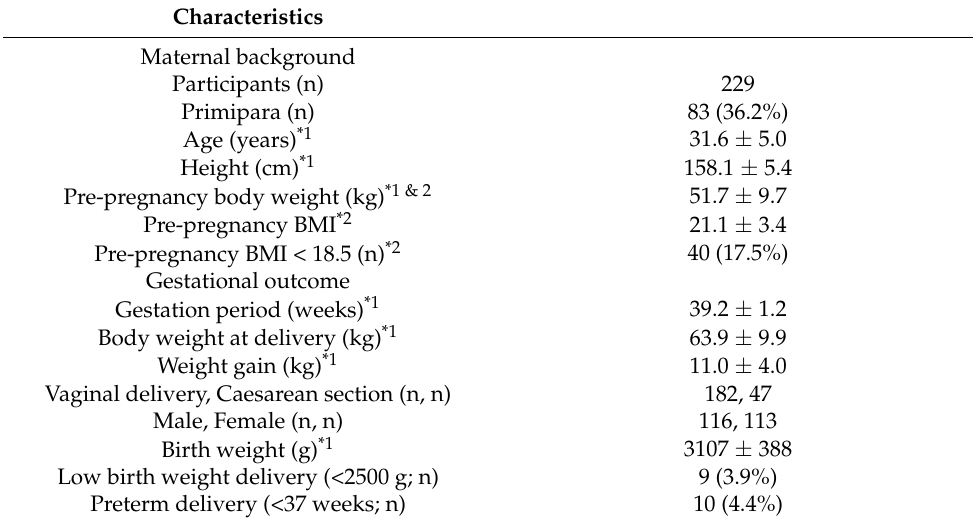
Table 1. Characteristics of participants.